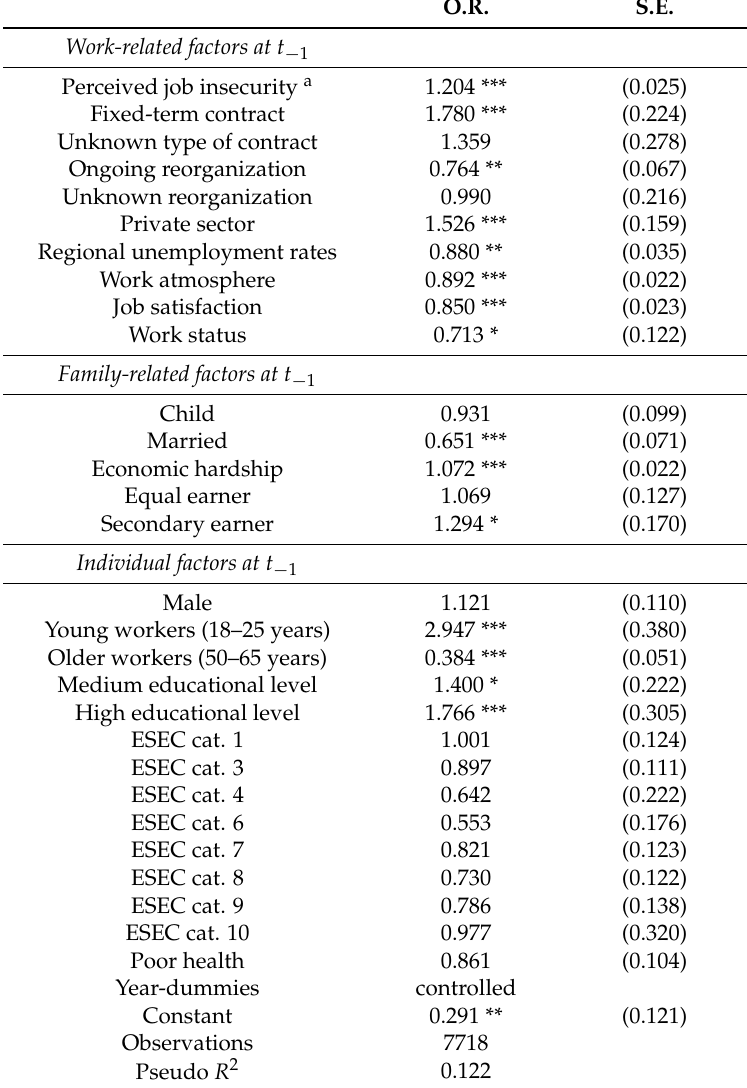
Table A1. Logistic regression estimating the propensity scores for voluntary turnover. Odds ratios are reported, data not